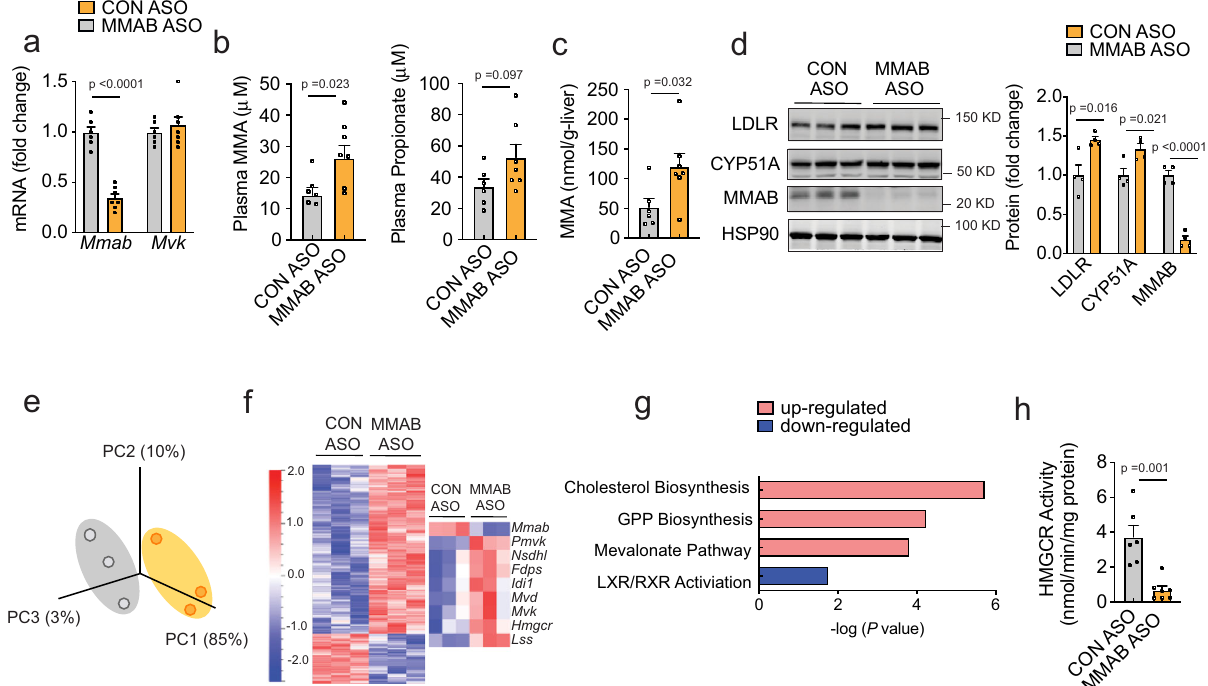
Fig. 7 Knockdown of MMAB reduces HMGCR activity and increases SREBP2-mediated gene expression in vivo. a qRT-PCR expression of Mmab and Mvk in 8-week-old C57BL/6 (WT) mice treated weekly with 50 mg/kg MMAB antisense oligonucleotide (MMAB ASO) or 50 mg/kg control antisense oligonucleotide (CON ASO) for 6 weeks. Data are mean ± s.e.m. n = 6 CON ASO, 7 MMAB ASO. Statistical comparisons by unpaired two-sided Student ’ s t test. b Plasma methylmalonic acid (MMA) and propionate in mice treated as in ( a ). Data are mean ± s.e.m. n = 6 CON ASO, 7 MMAB ASO. Statistical comparisons by unpaired two-sided Student ’ s t test. c Hepatic methylmalonic acid (MMA) in mice treated as in ( a ). Data are mean ± s.e.m. n = 6 CON ASO, 7 MMAB ASO. Statistical comparisons by unpaired two-sided Student ’ s t test. d Representative Western blot analysis of MMAB and SREBP2- responsive genes in the livers of mice treated as in ( a ). HSP90 was used a loading control. Quanti fi cation of blot shown to the right. Data are mean ± s.e.m. n = 4 mice per group. Statistical comparisons by unpaired two-sided Student ’ s t test. e Principle component (PC) analysis of RNA-seq data from liver tissue of mice treated as in ( a ). n = 3 mice per group. f Heatmap analysis of hepatic genes differentially expressed between CON ASO and MMAB ASO treated mice. Data are represented as Log2 (MMAB ASO/CON ASO treated) values. Genes in blue are downregulated, while genes in red are upregulated ( P ≤ 0.05; FC ≥ 1.5, FC ≤ − 1.5). Differentially expressed cholesterol biosynthetic genes are shown to the right (FDR adjusted, P ≤ 0.05; FC ≥ 1.5, FC ≤ − 1.5). n = 3 mice per group. g Pathway enrichment analysis of differentially expressed genes in the livers of CON ASO and MMAB ASO treated mice. Pathways with increased activity (positive Z -score) are highlighted in red, while pathways with decreased activity (negative Z -score) are highlighted in blue. See Supplementary Data 6. h HMGCR activity in the livers of mice treated as in ( a ). Data are mean ± s.e.m. n = 6 CON ASO, 7 MMAB ASO.